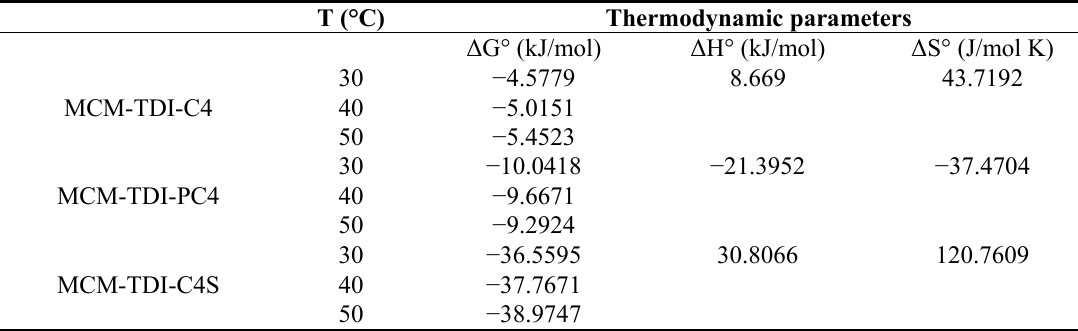
Table 3. Thermodynamic parameters of TBT